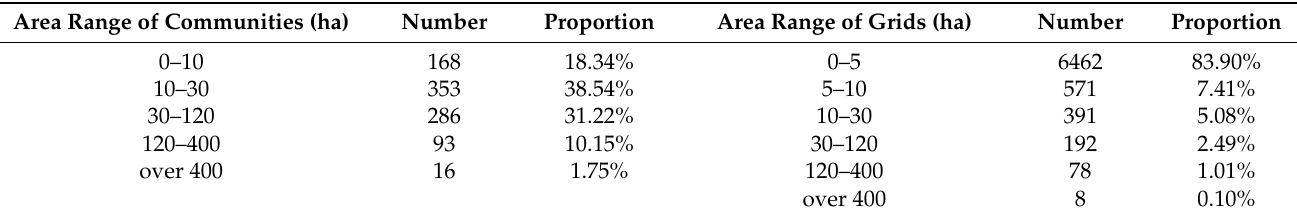
Table 2. Number and size of communities and basic geographical